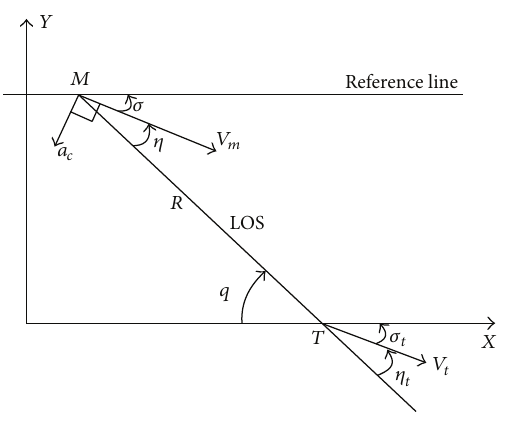
Figure 6: LOS planar pursuit geometry.